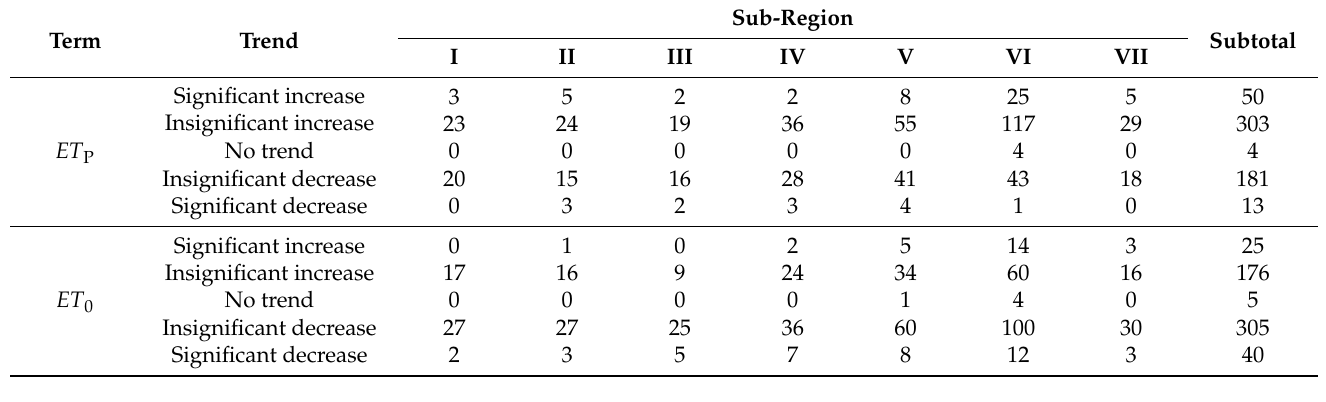
Table 2. The station numbers of annual ET o and ET p , which had different trends and levels of significance in different sub-regions.